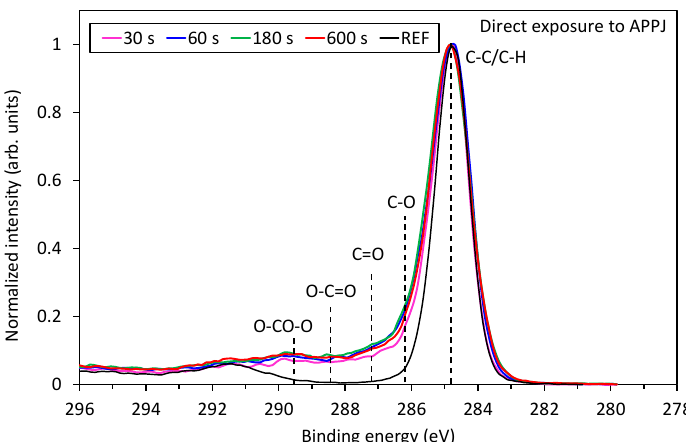
Figure 6. Comparison of high-resolution XPS C1s spectra of samples exposed directly to Ar plasma jet for various treatment times.